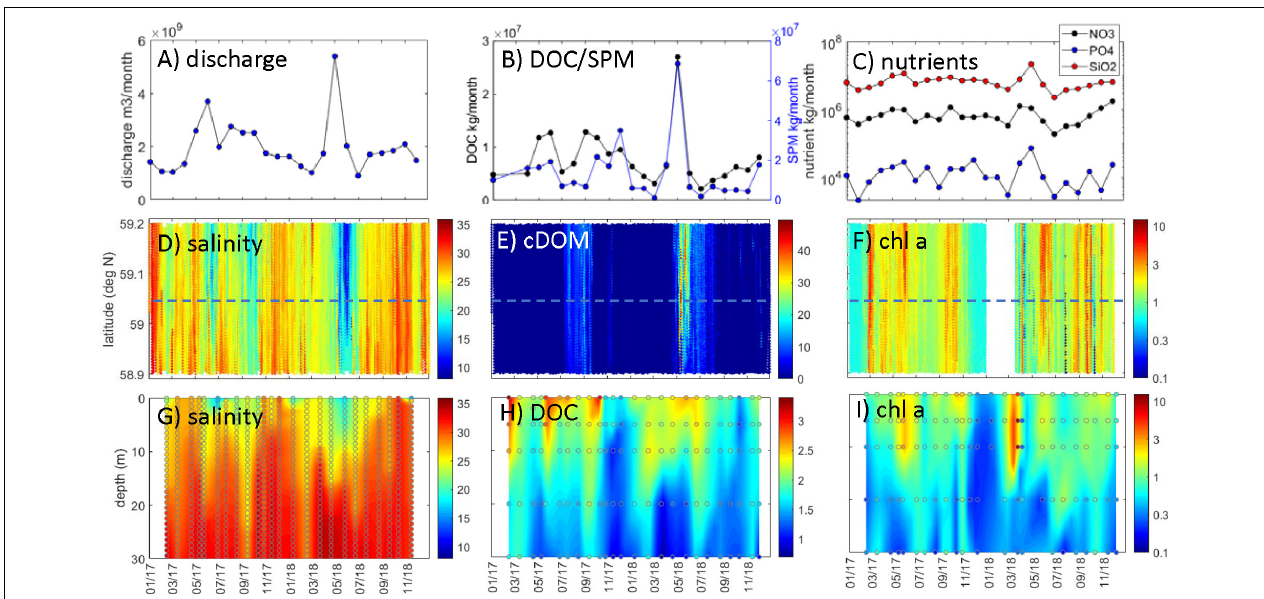
FIGURE 2 | Outer Oslofjord/southern Norway observations. Glomma river: (A) discharge (m 3 month − 1 ), (B) DOC transport (kg month − 1 ) and SPM transport (kg month − 1 ), and (C) nutrient transport (kg month − 1 ; black: NO 3 -N, blue: PO 4 -P, red: SiO 2 -Si). FerryBox observations within ∼ 5–15 km east of coastal station: (D) salinity, (E) cDOM fluorescence (arbitrary), and (F) chl a ( µ g L − 1 ; log scale). Water column station data [comparable latitude indicated by dashed blue line in panels (D–F) ]: (G) salinity, (H) DOC (mg L − 1 ), and (I) chl a ( µ g L − 1 ; log scale). Data in panels (D–I) were interpolated with actual data points superimposed.